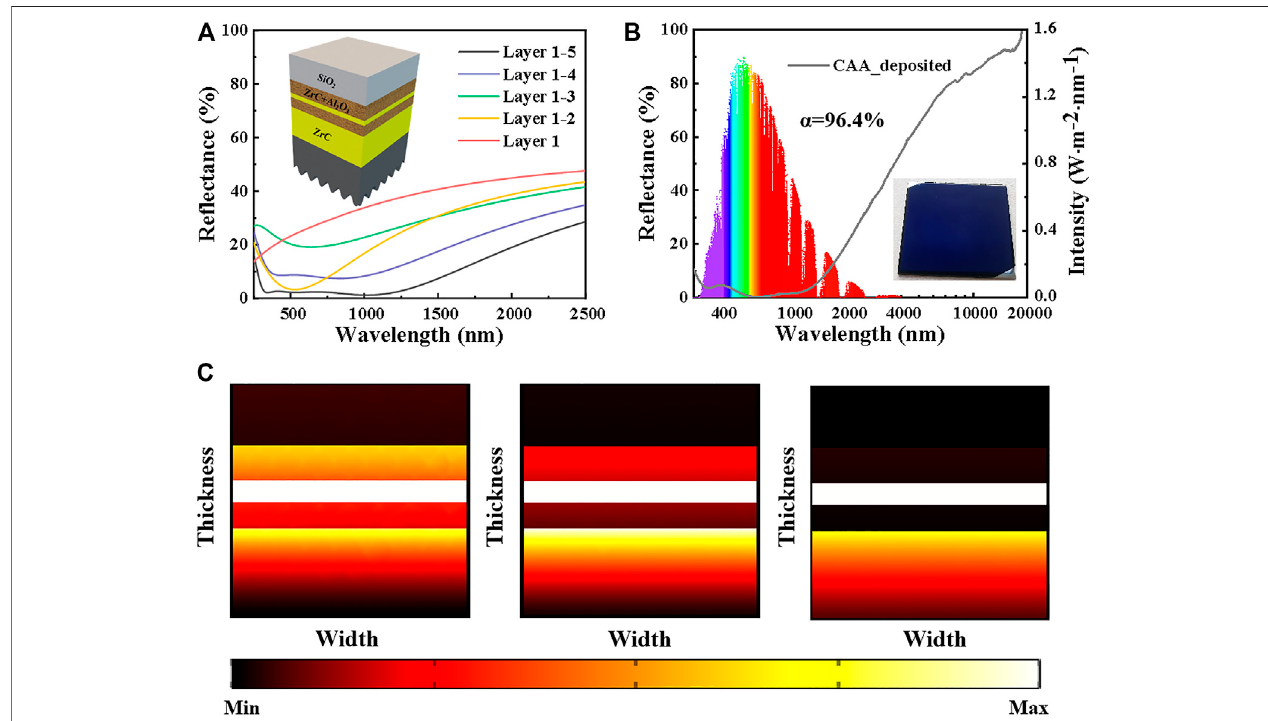
FIGURE2|(A) Simulated re fl ectancespectraofthelayer-addedcoatings andtheschematicoftheopticalstructure. (B) Themeasured are fl ection spectrum (gray line) the optical image of the CAA coating together with solar spectrum (AM 1.5, polychromatic block). (C) The distribution of electromagnetic power loss of the CAA at the wavelengths of 0.62, 1.11, and 2.5 μ m, where λ (cid:2) 0.62 μ m is connected with the re fl ectance